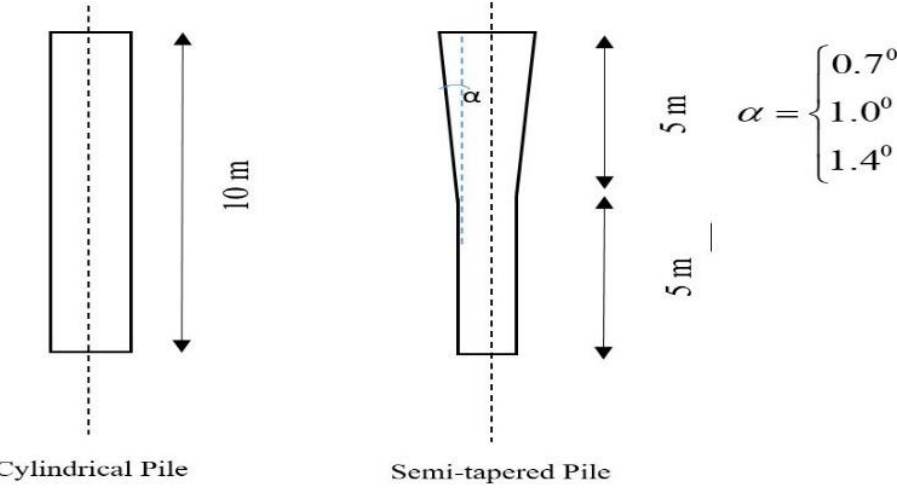
Figure 10. The geometry of concrete piles.